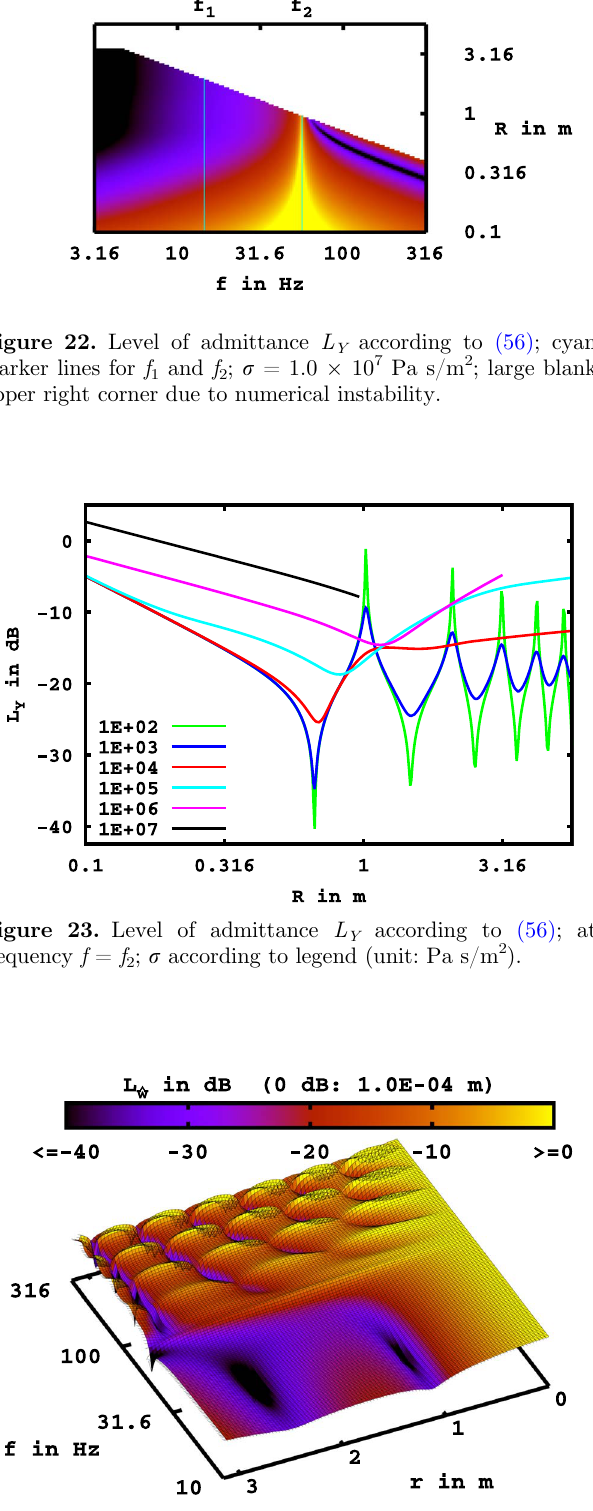
Figure 24. De fl ection level L ^ w , concrete plate, R = 3.16 m, ^ w (cid:5) 10 (cid:4) 4 m, further values from Table 1, open boundary 0 = 1 according to